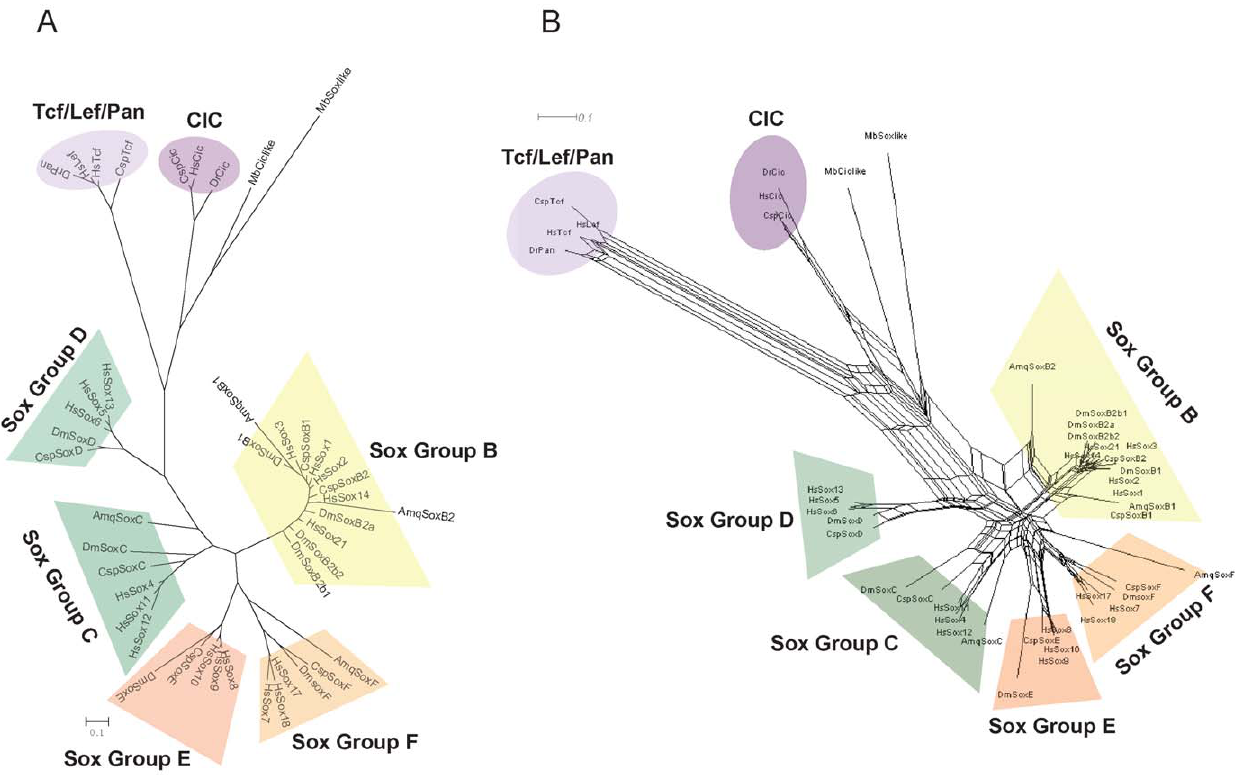
Figure 1. Bayesian tree and split network of representative metazoan proteins based on an HMG domain alignment with Sox, Cic and Tcf/Lef/Pan sequences of the human, Drosophila , and annelid, and Sox-like and Cic-like sequences of the choanozoan. (A) Bayesian tree is shown, reconstructed under the RtREV + G (gamma distribution) model. (B) Split network reconstructed under the JTT model. Abbreviations of species names are as in Table